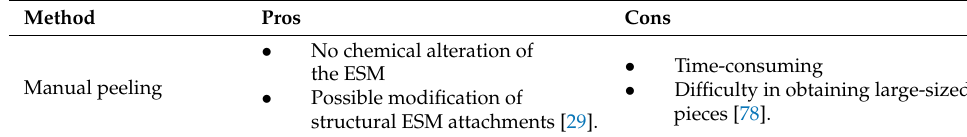
Table 2. Different ESM separation methodologies indicating their pros and cons.